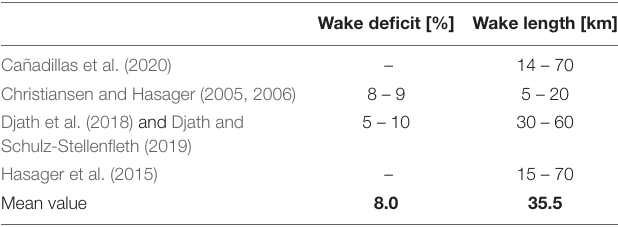
TABLE 1 | Compilation of wind speed deficit α and wake length σ observations of satellite SAR and airborne